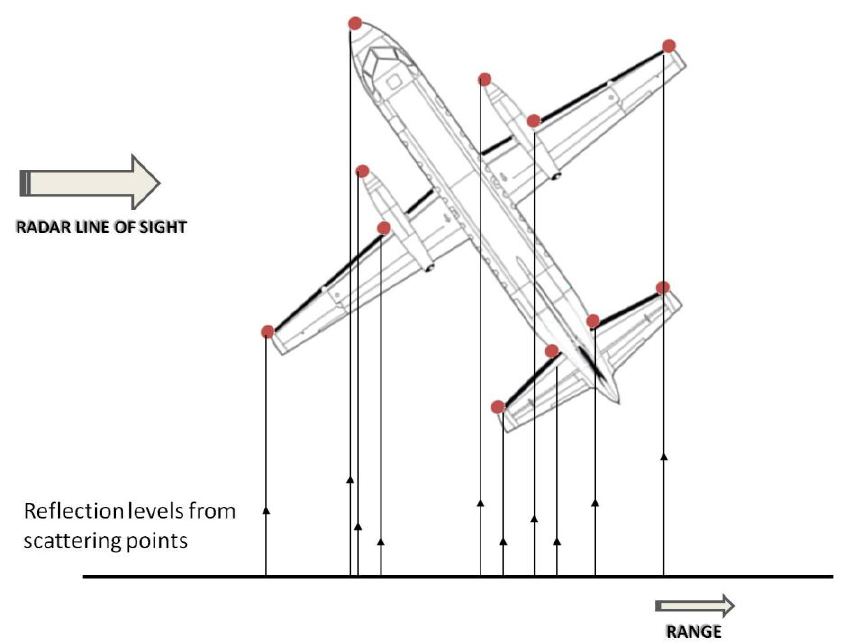
Figure 2. Example of scattering centers in a